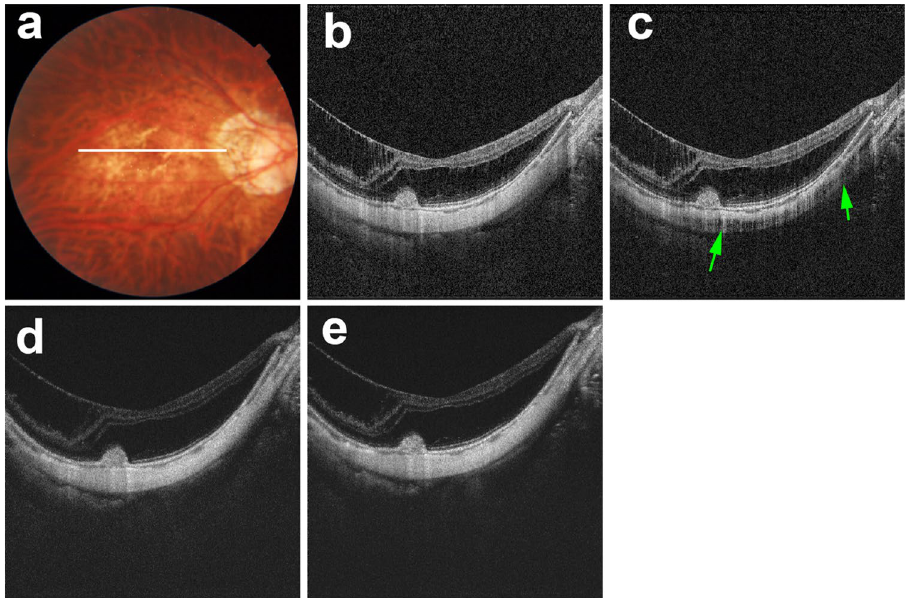
Figure 6. Low-intensity band artifact in a polarization-dependent OCT image. The right eye of a 33-year-old man who had macular retinoschisis with myopic choroidal neovascularization in remission is shown. White line in color fundus image ( a ) indicates the scan line for PD-OCT images and commercial OCT B-scan images ( b – e ). Polarization-dependent OCT B-scan image ( c ) shows a low-intensity band artifact (green arrows). No low-intensity band artifacts are present in a polarization-independent OCT B-scan image ( b ) or two repeated commercial OCT B-scan images ( d , e ).